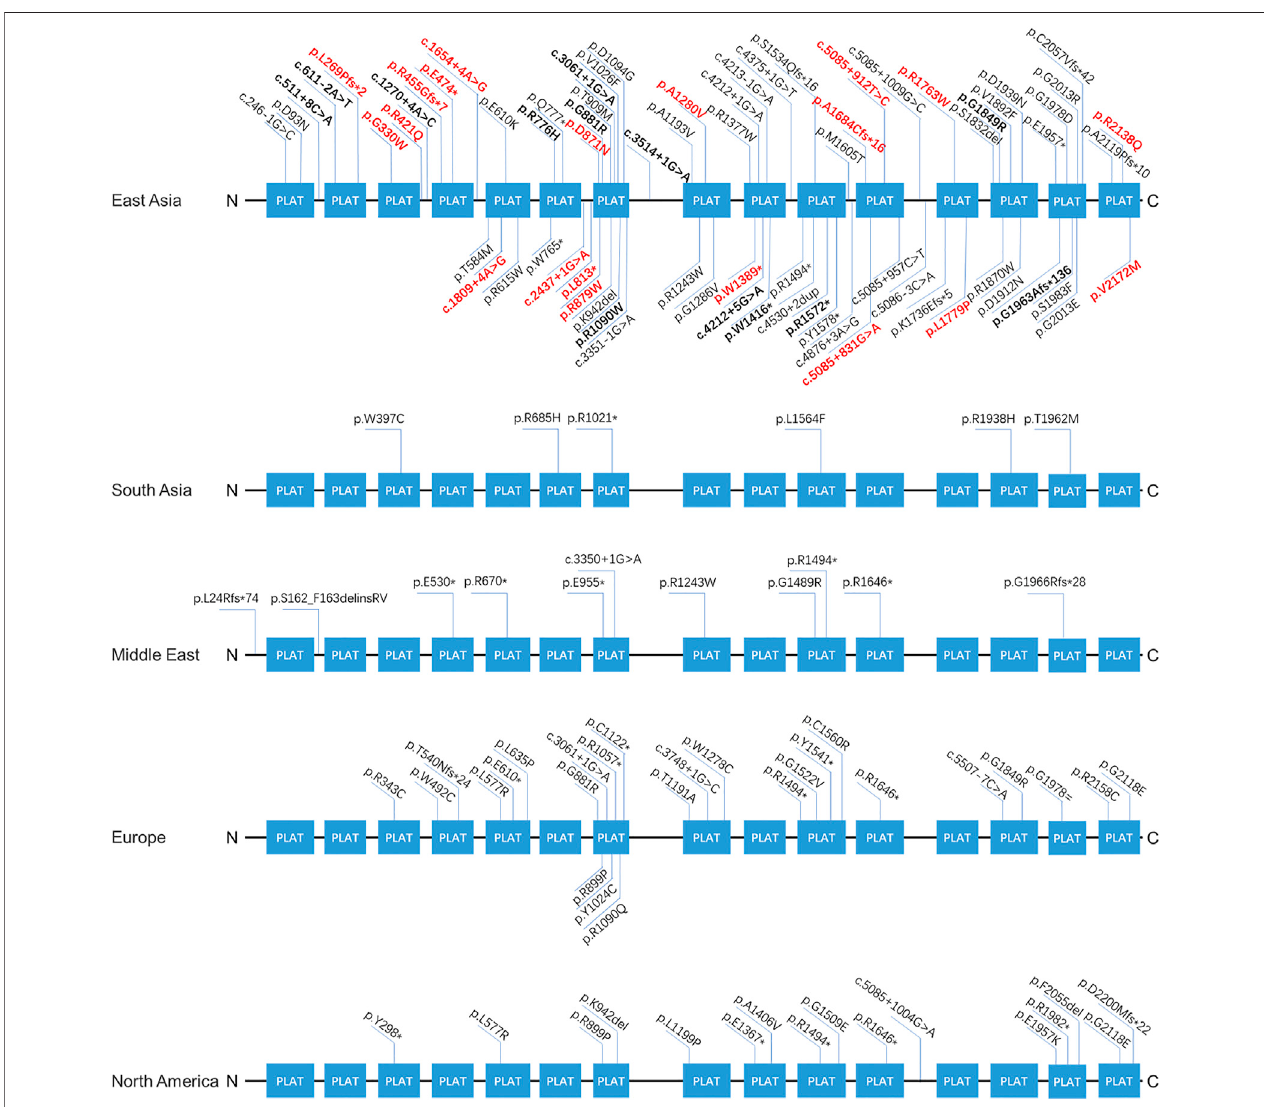
FIGURE 3 | The spectra of LOXHD1 variants in different populations. The LOXHD1 gene here and its protein consists of 15 PLAT domains (NM_144612, NP_653213). All variants identi fi ed in this study are marked in bold, the novel variants are highlighted in red in the meantime.